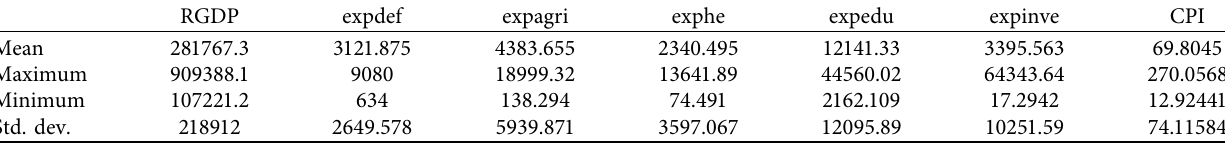
Table 3: Descriptive statistics of the economic variables (1980–2018 millions of